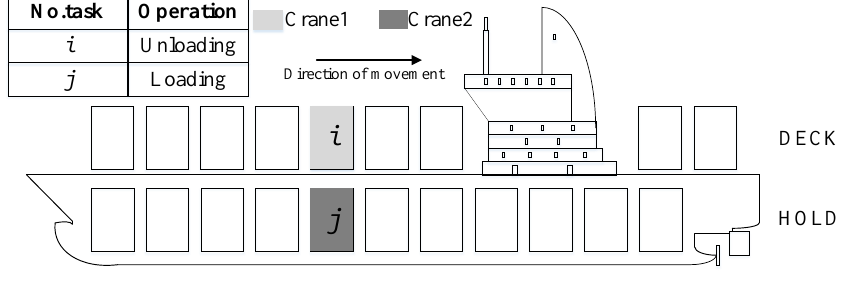
Figure 1. Example of the violation of branching criterion